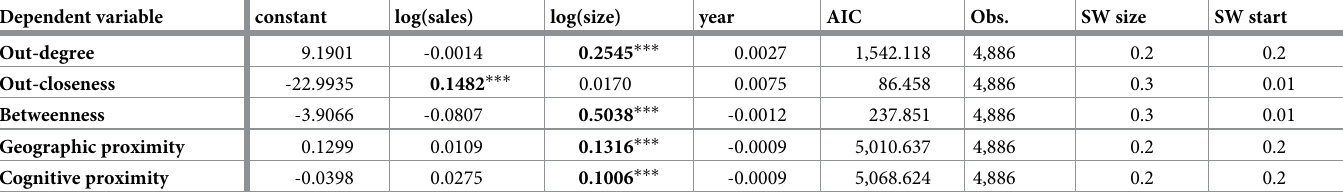
Table 4. Influence of company characteristics on similar connection strategies in the Hyperlink and Follower